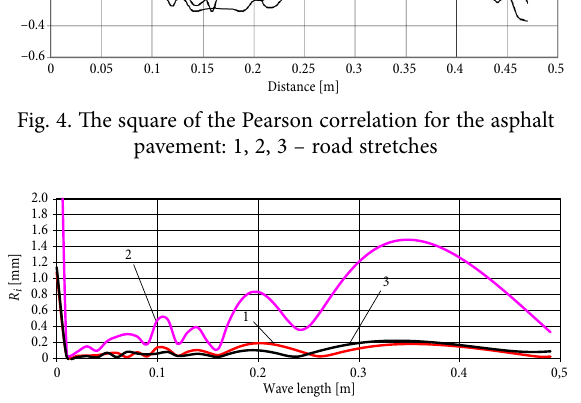
Fig. 5. Dependences of amplitudes on the predominant wave length values: 1, 2, 3 – road stretches